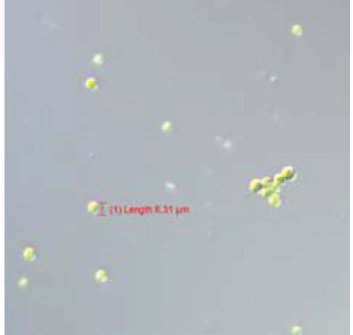
Fig. 6b. Morphological observation of Chlorella sp. Carolina-15-2069 with 40X magnification.